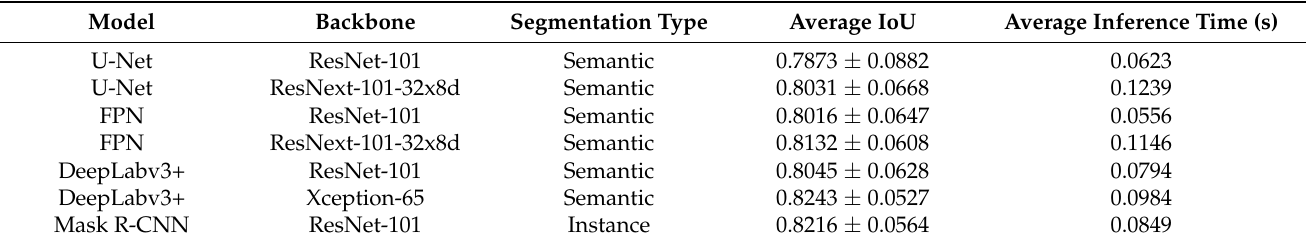
Table 1. Performance of MN segmentation using different models with varied